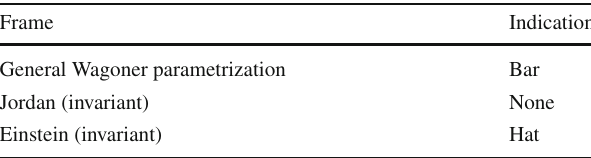
Table 1 Summary of quantities used in different frames Frame